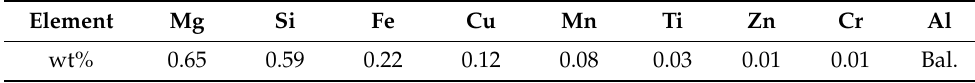
Table 1. The chemical composition of AA6014 alloy.